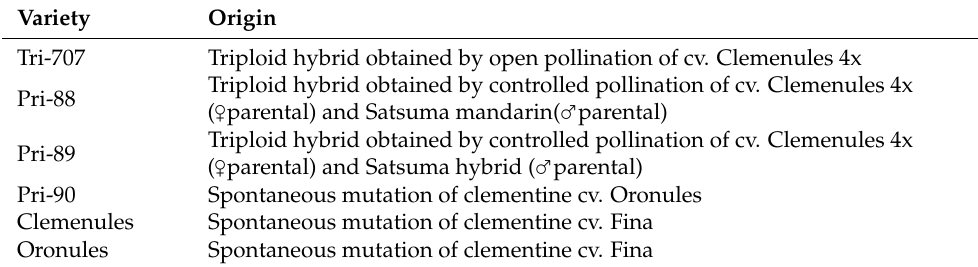
Table 1. Origin of